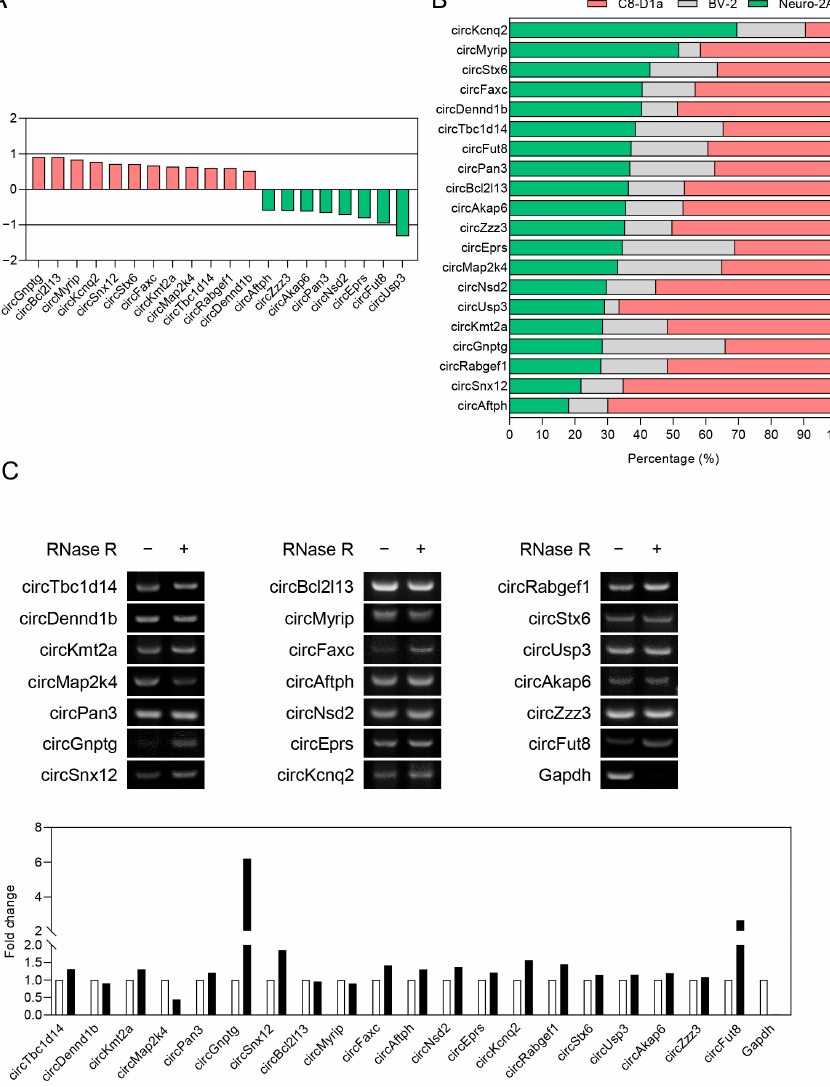
Figure 1. Differential expression and cell-type specificity of obesity-linked circRNAs in the brain. ( A ) A histogram displaying the differential expression of circRNAs in the brain cortices of obese mice compared to wild-type mice. The data are expressed as the average Log 2 fold change ( n = 4). ( B ) Stacked bars showing the cell-type specific expression of obesity-linked circRNAs in three mouse-brain cell lines. The total circRNA expression in the three cell lines is set at 100%, and the relative distribution of circRNAs in each cell line is expressed as percentages ( n = 3). ( C ) Circular structure confirmation of circRNAs. Cropped bands showing the expression of circRNAs and Gapdh in untreated ( − ) and RNase R-treated (+) Neuro-2A mouse neuroblastoma cells. A histogram displaying changes in expression of circRNAs and Gapdh in RNase R-treated [RNase R (+)] Neuro-2A cells compared to untreated control cells [RNase R ( − )]. CircRNAs’ structure confirmation results from a comparative analysis of the expression value of Gapdh mRNA (linear) and the expression value of circRNAs (circular) in the RNase R (+) group. The data are expressed as a relative value of the RNase R-treated group when the untreated control value is 1. Neuro-2A: mouse neuroblastoma cells, BV-2: mouse microglial cells, C8-D1a: mouse